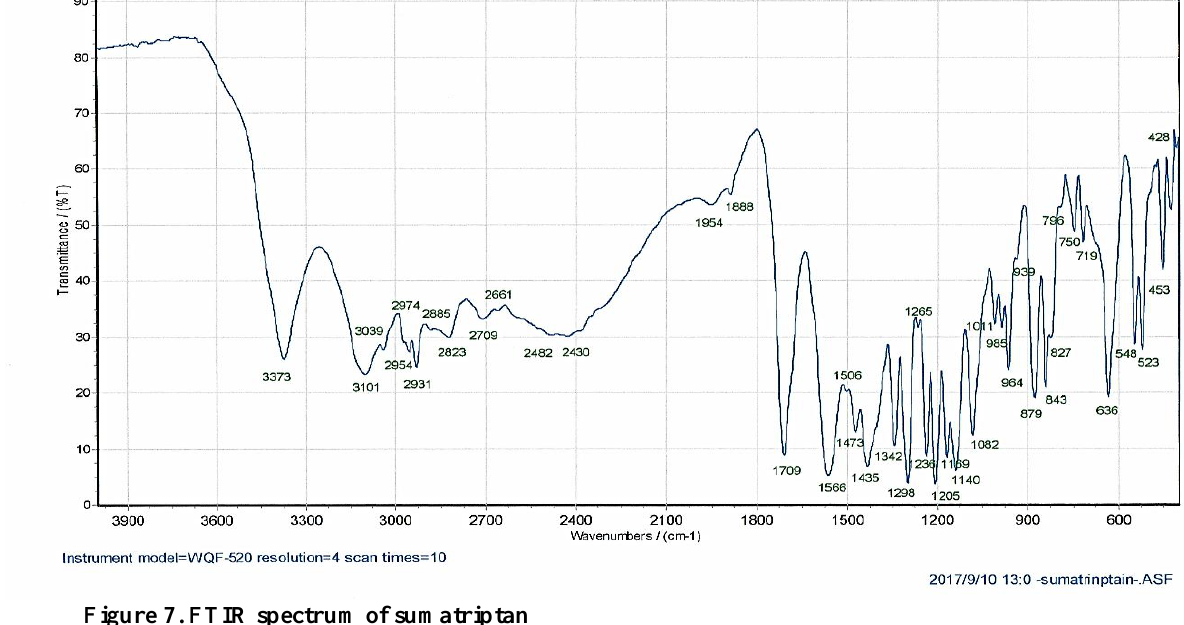
Figure 7. FTIR spectrum of sumatriptan